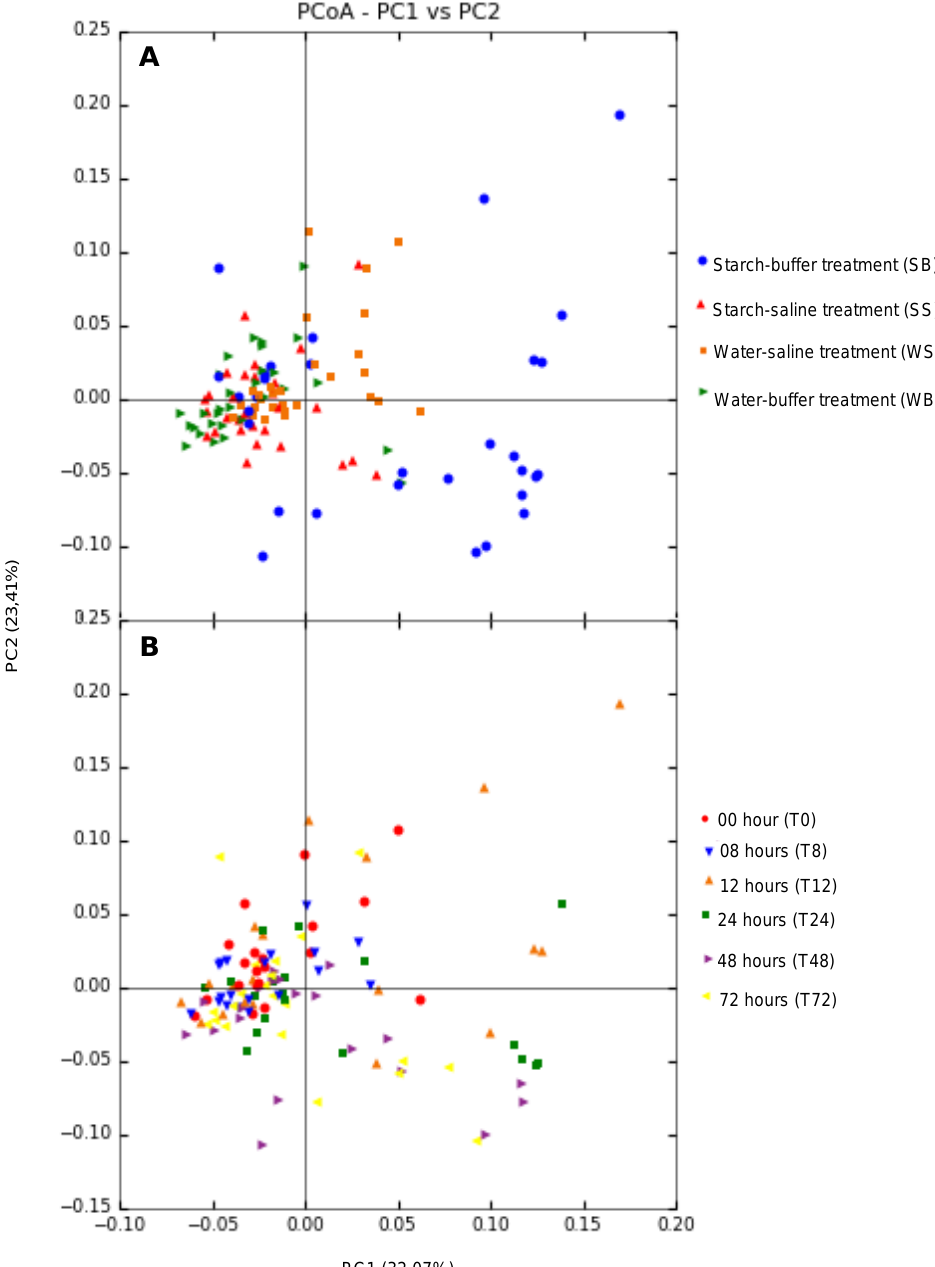
Figure 2. Principal coordinates of the UniFrac weighted distance for the bacterial communities based on treatment and sampling intervals. The UniFrac distance is a mensuration of β -diversity, or the extension of the relation among the bacterial communities. ( A ) treatment; ( B ) sampling interval. The percentages in parentheses in the axis titles represent a variation of 55.48%, explained by the principal